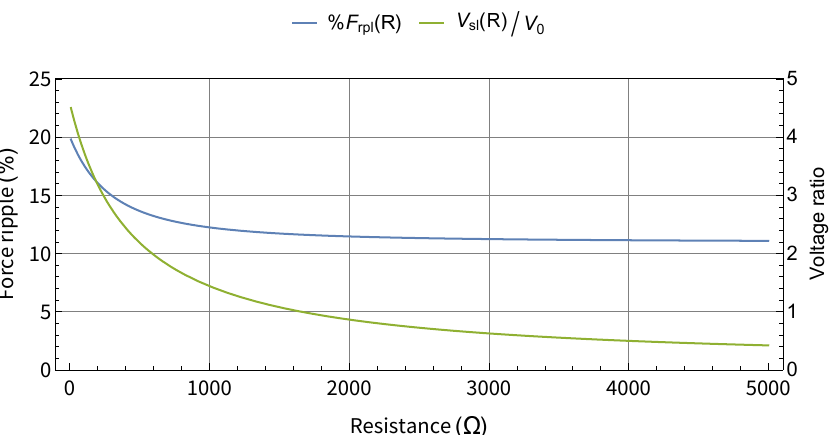
Figure 6. Voltage amplitude ratio and % F rpl as a function of resistance with resistance (in the range of 10 to 5000 Ω ), for the considered model parameters. V sl was calculated for θ x = π / 8 , for which its value is